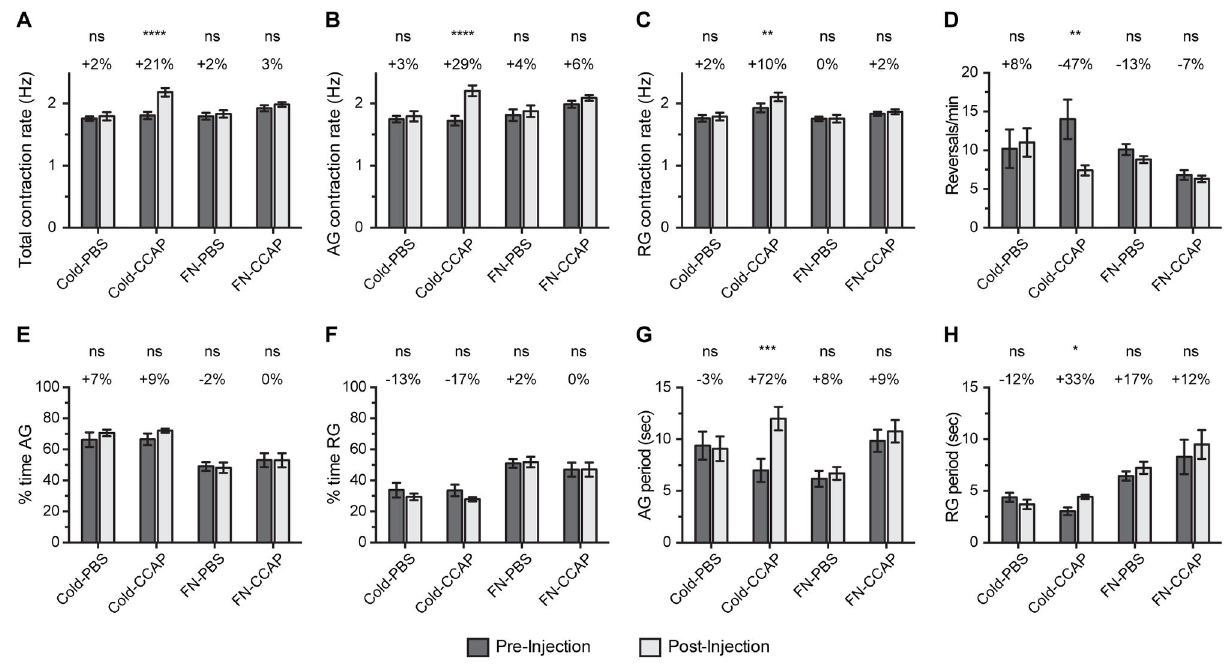
Figure 5. Effect of CCAP on heart physiology following cold or FlyNap anesthesia. Four groups were assayed: (1) cold anesthesia followed by PBS injection; (2) cold anesthesia followed by 1 X 10 -5 M CCAP in PBS; (3) 30 sec FlyNap (FN) anesthesia followed by PBS injection; (4) 30 sec FlyNap anesthesia followed by 1 X 10 -5 M CCAP in PBS. The following heart parameters are reported: (A–C) total, anterograde and retrograde contraction rate; (D) frequency of heartbeat directional reversals; (E–F) percent time contracting in the anterograde and retrograde directions; (G–H) anterograde and retrograde period lengths. Data were initially analyzed by repeated measures two-way ANOVA, and for each treatment group the statistical significances between the pre- and post-injection datasets are denoted using asterisks (Sidak’s multiple comparison’s post-hoc test: ns, P>0.05; *, P<0.05; **, P<0.01; ***, P<0.001; ****, P<0.0001). The percentages reported above each set of columns report the percentage change between pre- and post-injection. Bars denote the standard error of the mean. For all groups, N = 10. doi: